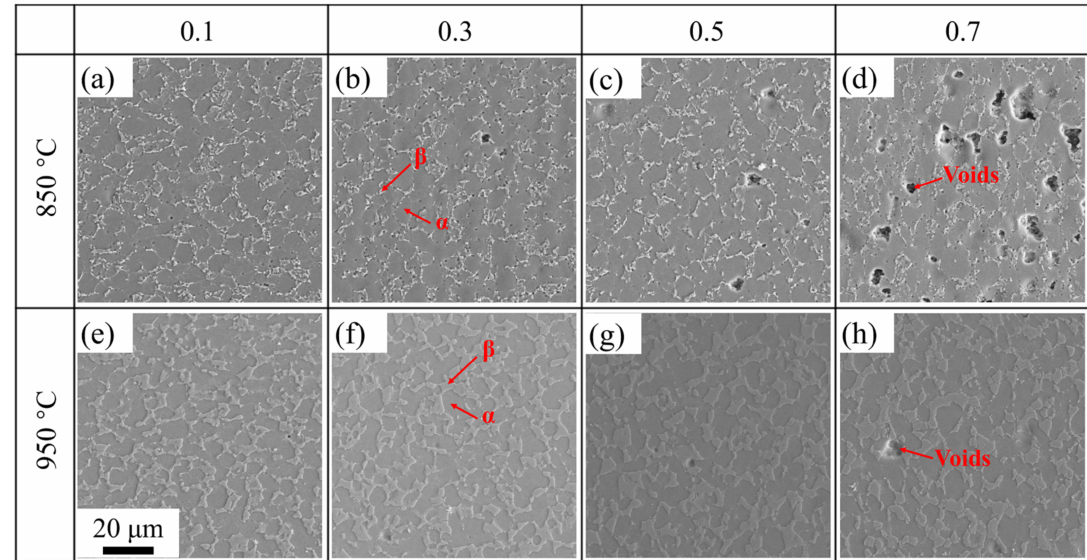
Figure 7. Microstructure at different temperatures and strains when deformed at 0.01 s − 1 : ( a – d ) 850 ◦ C; ( e – h ) 950 ◦ C; ( a , e ) strain 0.1; ( b , f ) strain 0.3; ( c , g ) strain 0.5; ( d , h ) strain